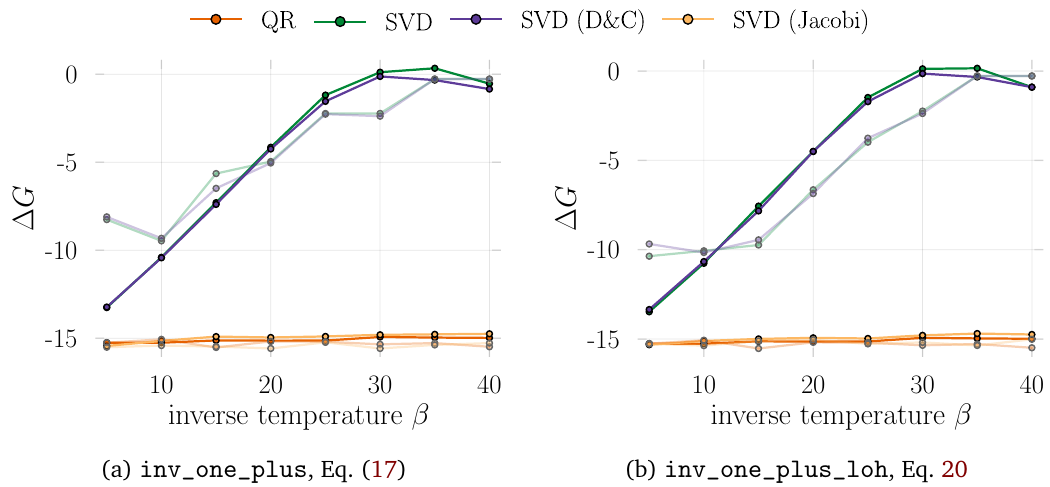
Figure (4) Accuracy of the Green’s function obtained from stabilized compu- tations using the listed matrix decompositions and inversion schemes. Shown is ∆ G = log ( max ( abs ( G − G ))) for U = 0 (solid) and U = 1 (alpha exact